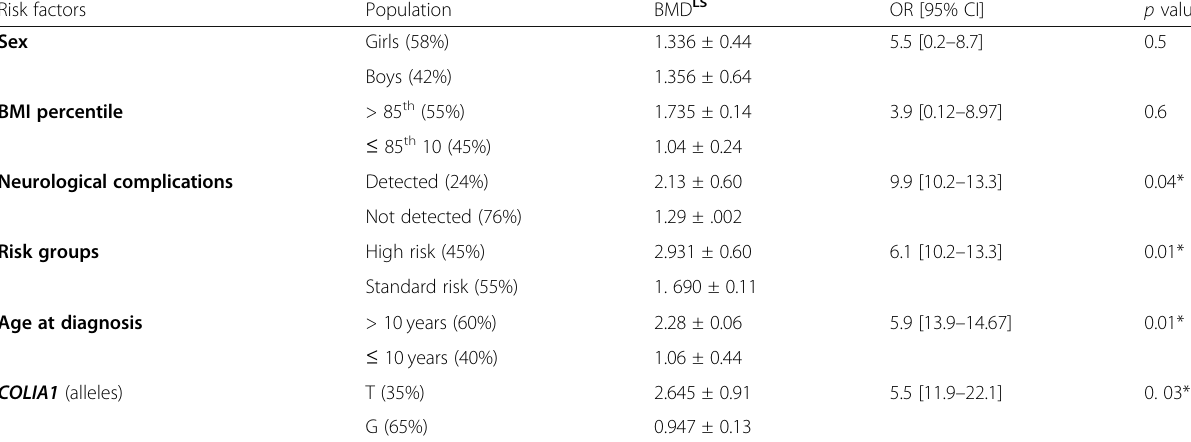
Table 6 Multivariate analyses of different risk factors affecting bone mineral density of lumbar spine (BMD LS ) in acute lymphoblastic leukemia patients after 3 years (the second assessment)